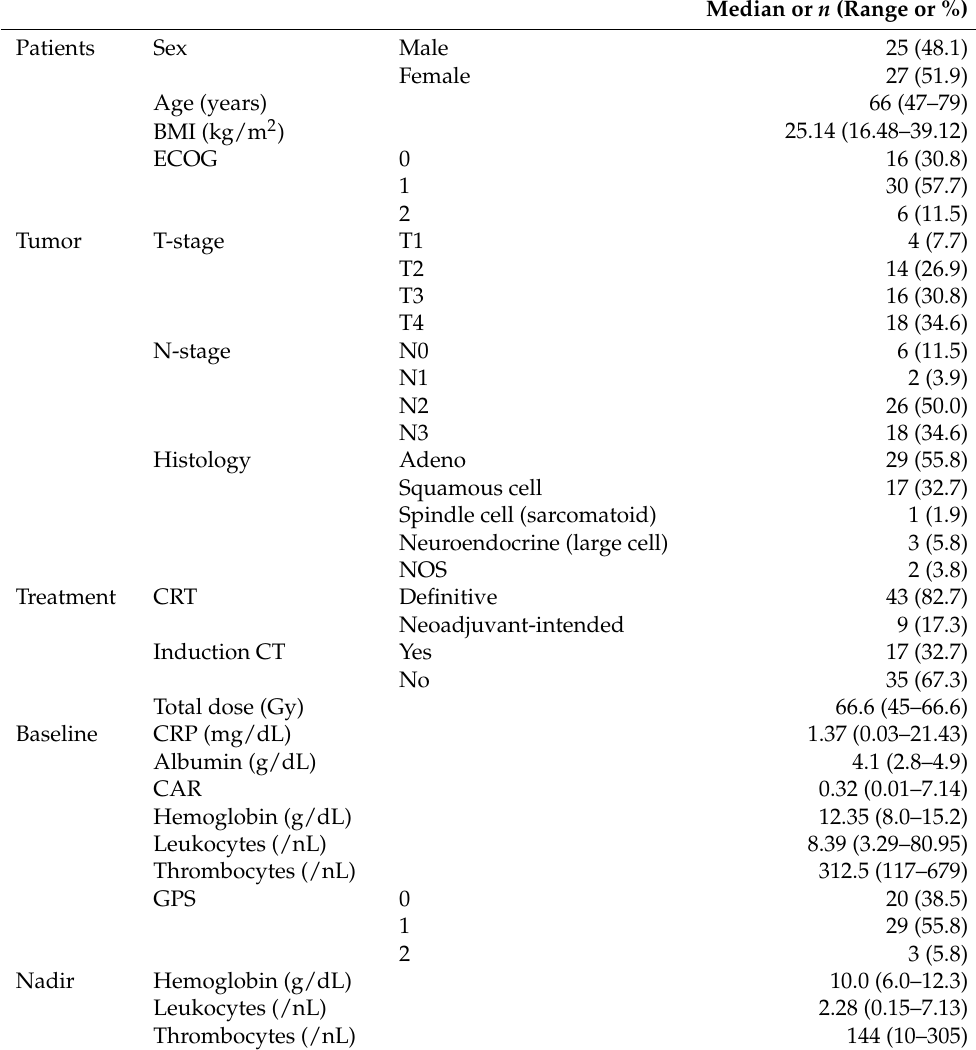
Table 1. Patient, disease, treatment, blood